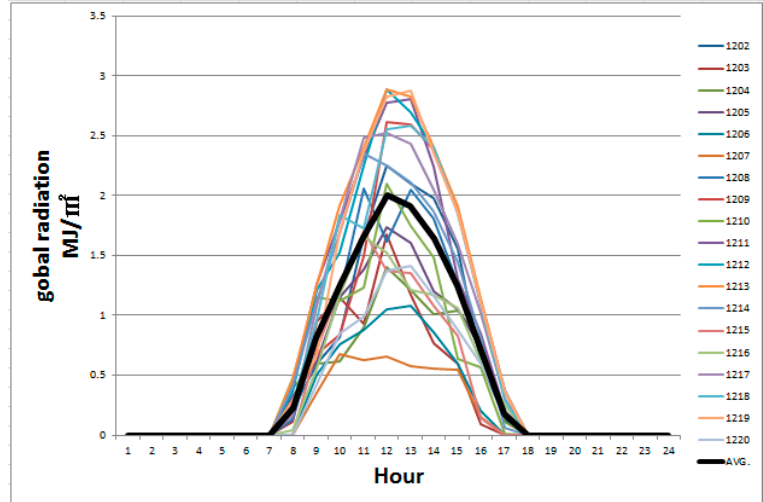
Figure 8. Global radiation scenarios of Jianshan/Cimei photovoltaics (PVs).